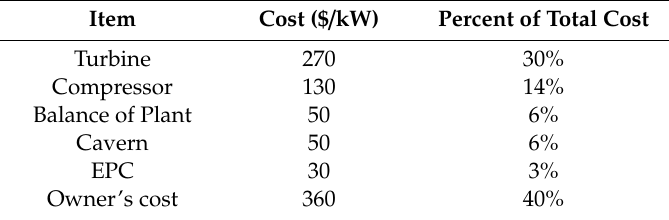
Table 32. CAES capital cost breakdown by component, Black and Veatch (2012) [28]. Item